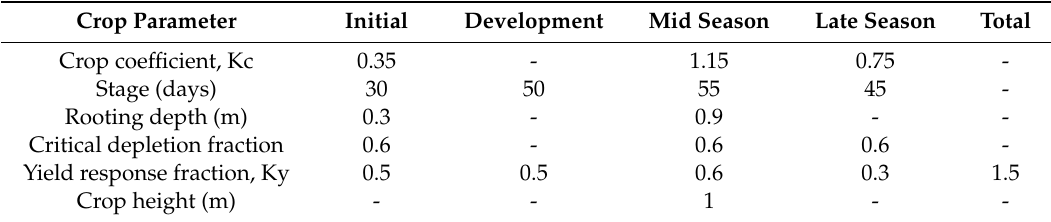
Table A9. Crop data used in CROPWAT to calculate crop water use (CWU) [29,91]. Crop Parameter